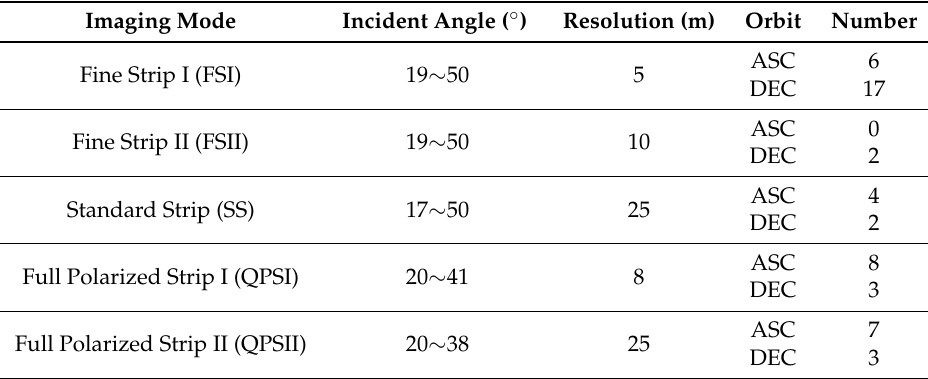
Table 1. Information of GF-3 dataset in our experiments.